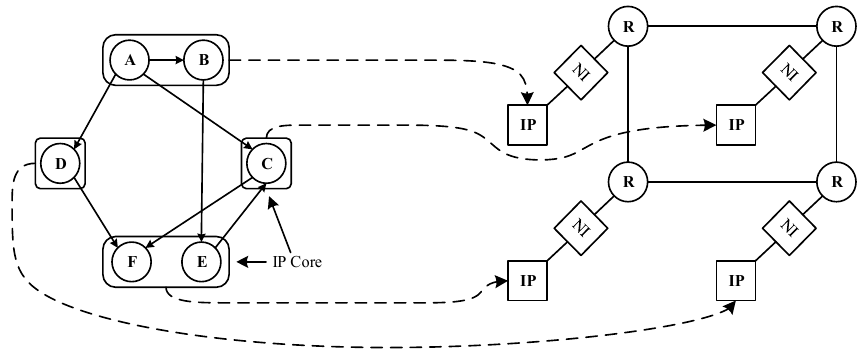
Figure 2. The second step of NoC mapping: IP core mapping .